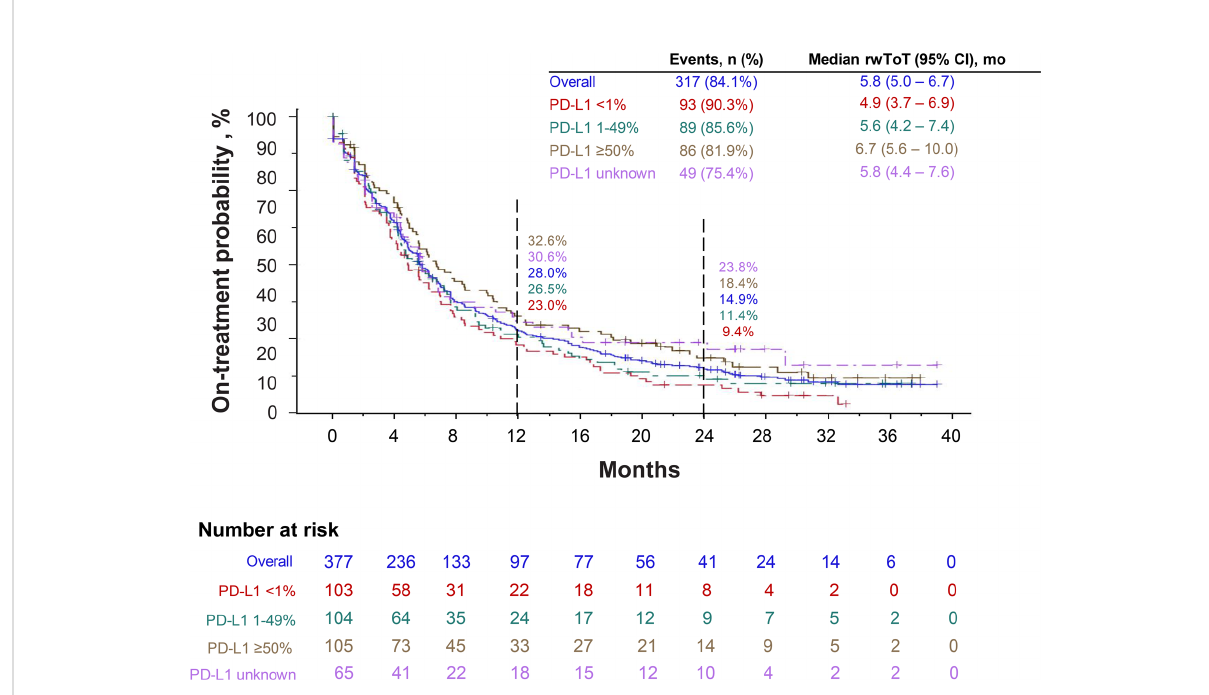
FIGURE 2 Real-world time on treatment (rwToT) with fi rst-line pembrolizumab, when administered in combination with pemetrexed and